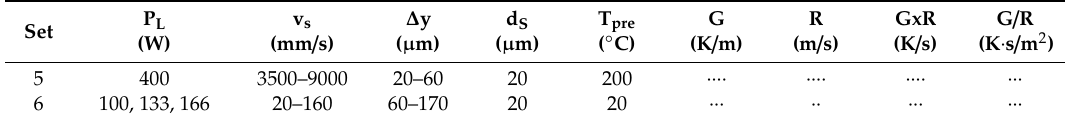
Table 4. Varied parameters in the second evolvement